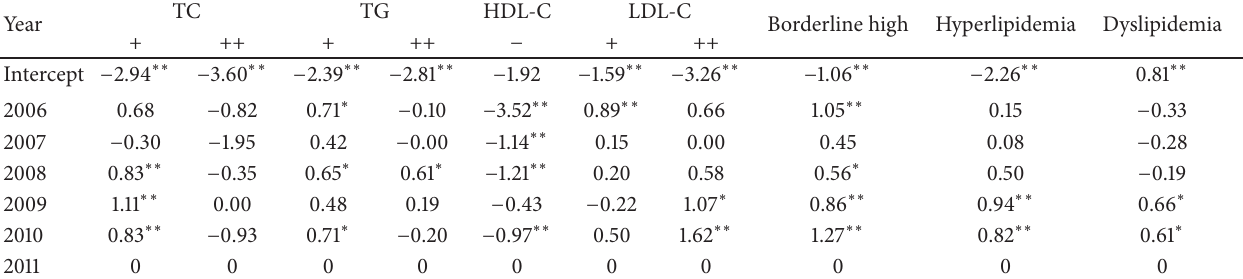
Table 5: Fixed coefficients of each lipid parameter in Chinese civil aviators in generalized linear mixed model 2006–2011 ( 𝑁 = 305 ).